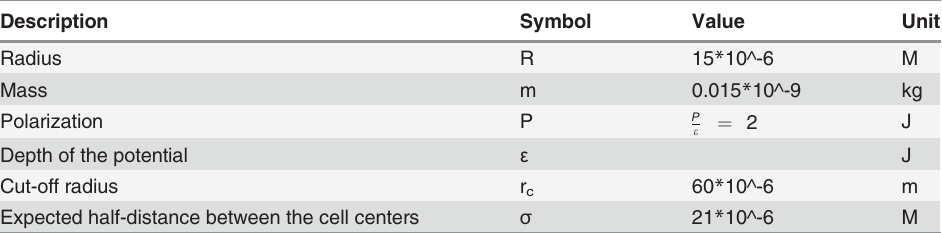
Table 1. Model parameters for the simulation of cell migration of the ctr cells used throughout this work.